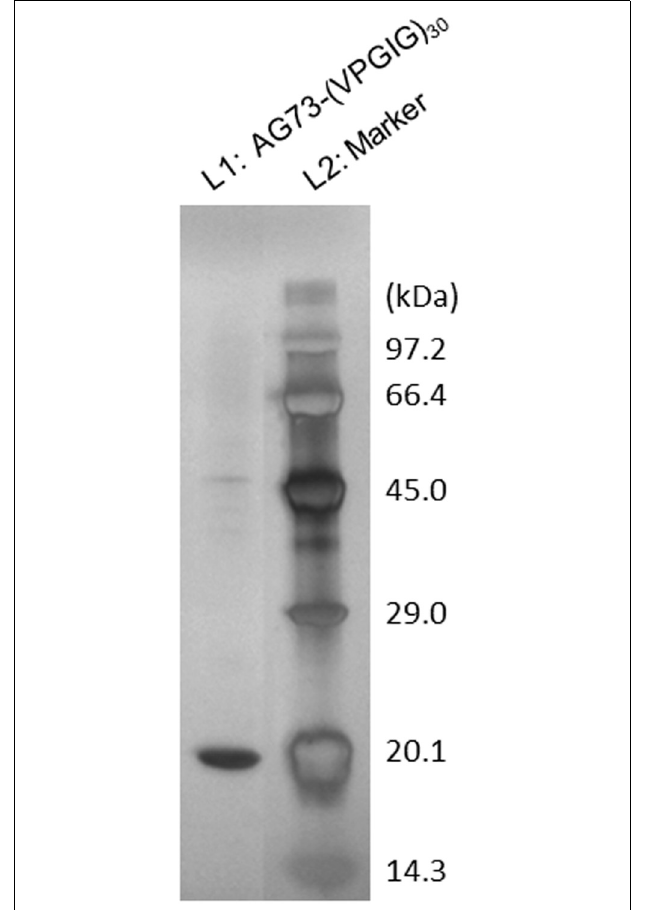
FIGURE 1 | Silver staining of the gel after SDS-PAGE of purified AG73-(VPGIG) 30